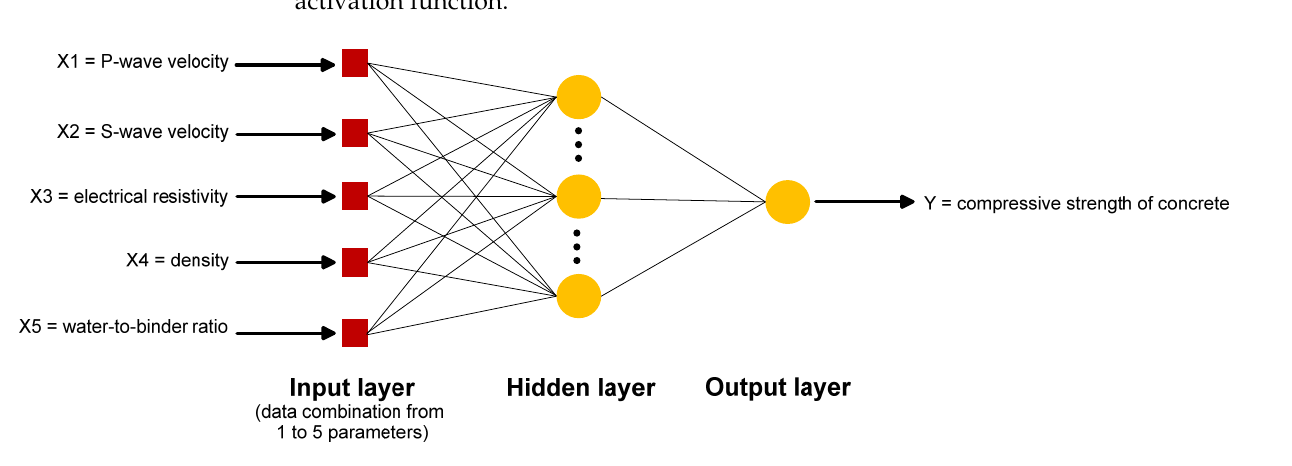
Figure 6. Schematic diagram for the ANN architecture used in analysis: this specific architecture considers the combination of five parameters for strength estimation.